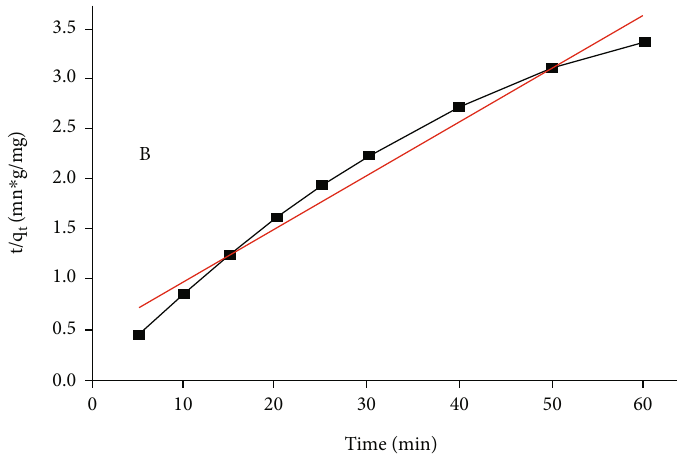
Figure 12: Nonlinear fi tting of PSO kinetic for Cr(VI) ion adsorption from aqueous solution.